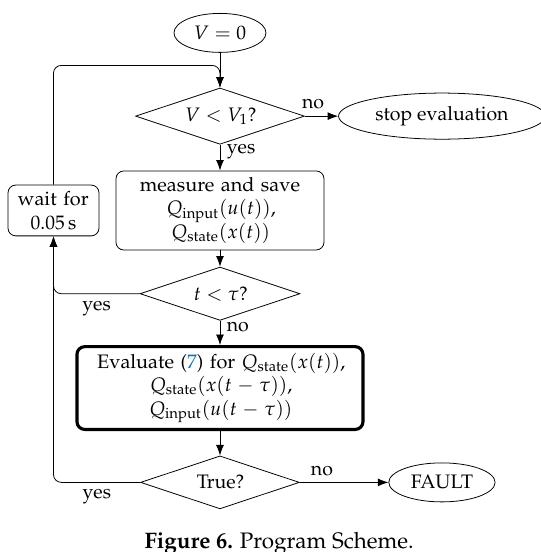
Figure 6. Program